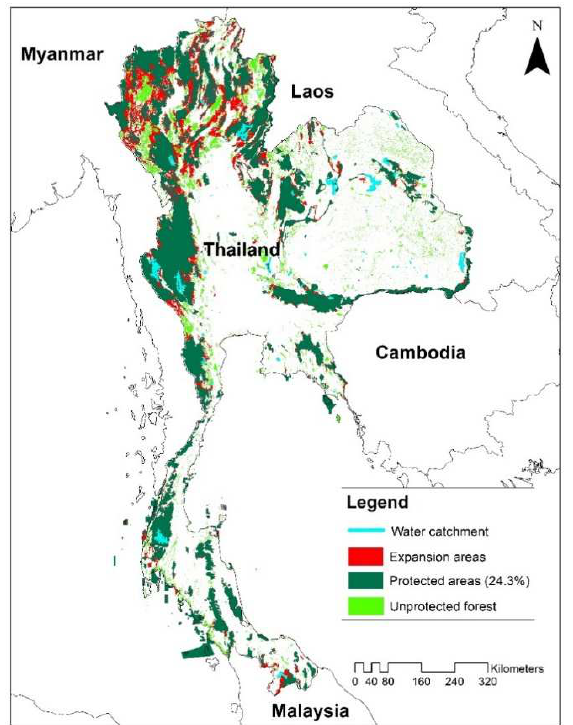
Figure 2. Proposed expansion areas to bring the protected area coverage to 29.5% from the existing 24.3%.